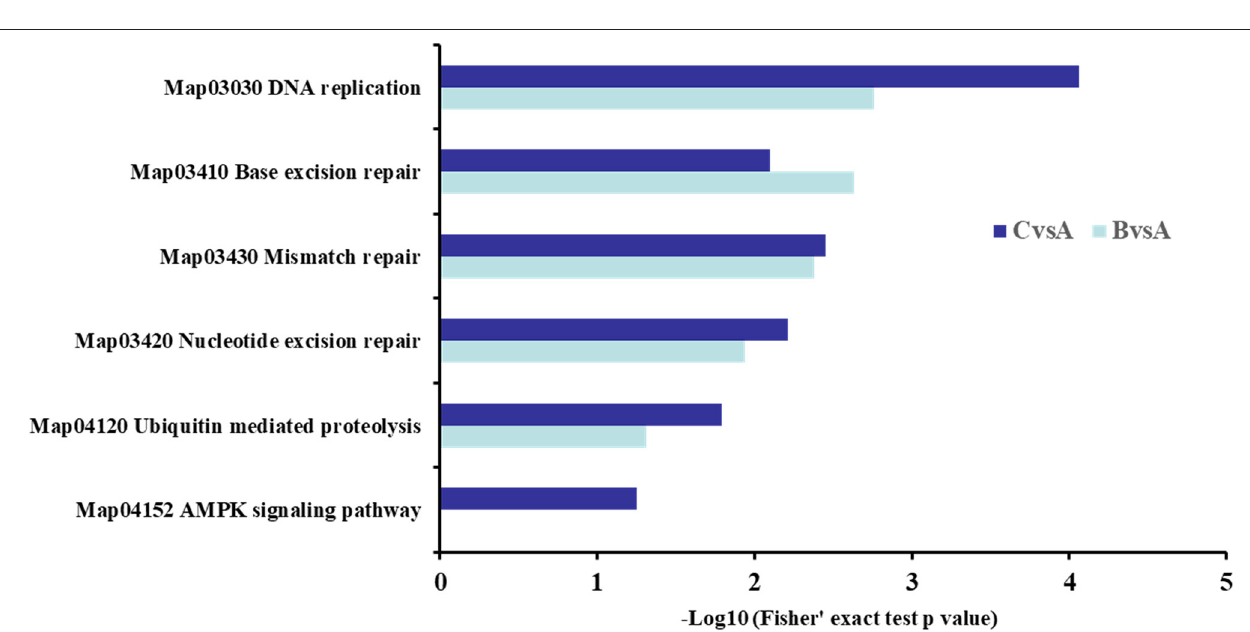
FIGURE 8 | KEGG analysis in DST. BvsA indicated the differential proteins enriched in 0.5 mg/mL SBA treatment compared to control (0.0 mg/mL SBA treatment), CvsA indicated the differential proteins enriched in 2.0 mg/mL SBA treatment compared to control.